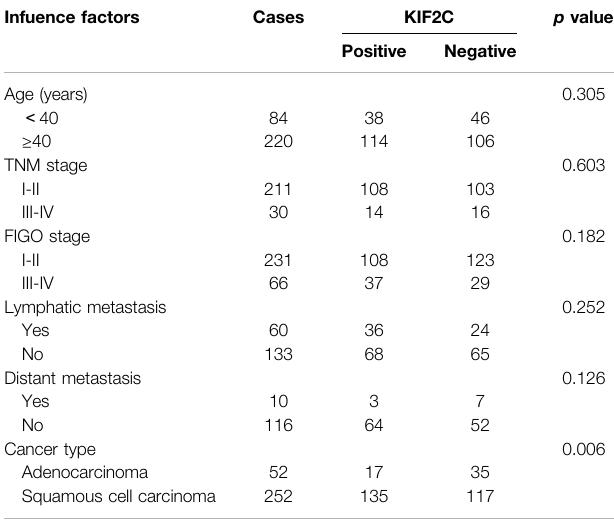
TABLE 2 | Relationship between KIF2C and clinicopathological characteristics in cervical cancer patients. Infuence